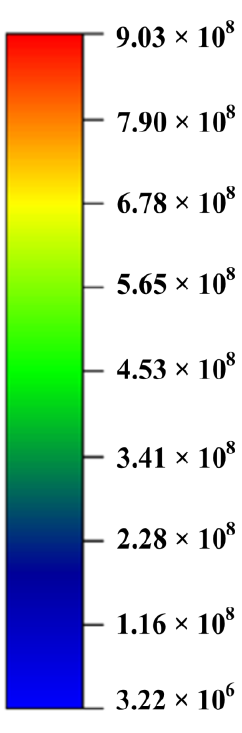
Figure 3. Color bar indicating the intensity of light. Table 4 indicates the values of output power (P Y ) obtained by providing a optical input power signal at a low intensity of 0.7 × 10 9 W/m and high intensity of 3 × 10 9 W/m for the inputs (A 0 and A 1 ) and control signal (S). A normalized power of 0.5 is used as the